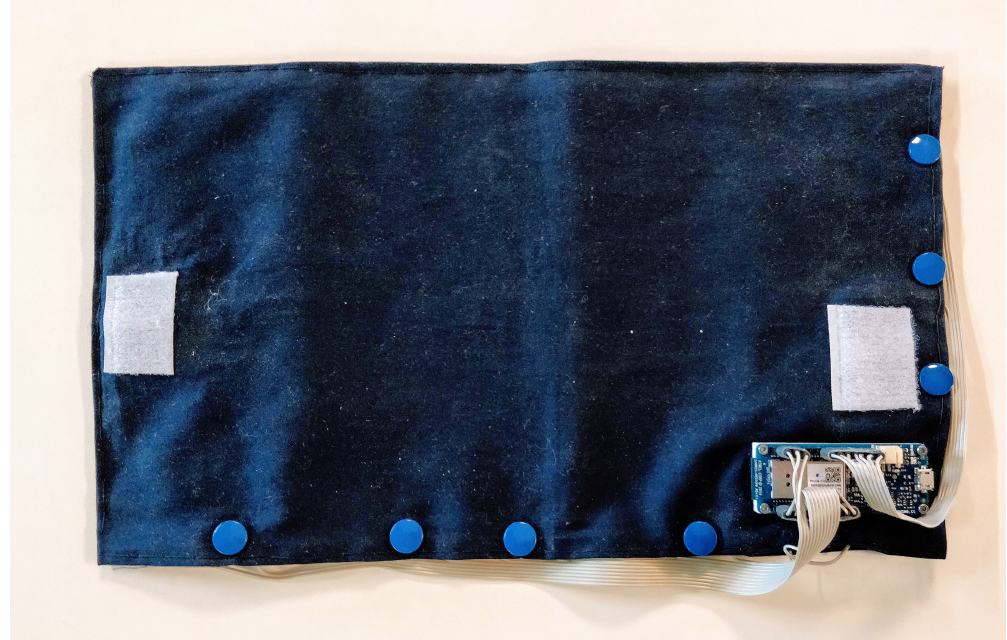
Figure 3. Our resulting implementation of a smart textile which is able to detect and translate local forces to a state configuration (for example, folded or unfolded). The smart textile is made using accessible off-the-shelf materials and tools.